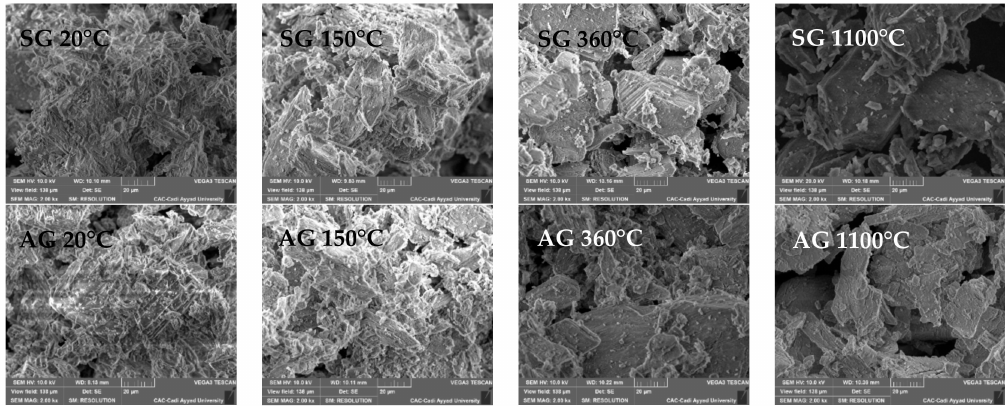
Figure 8. SEM images of SG and AG samples treated at various temperature of